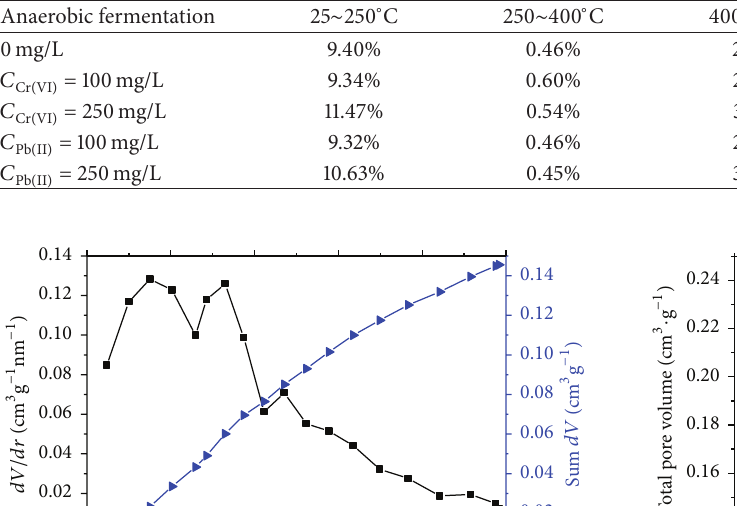
Table 7: Percentage of weight loss.